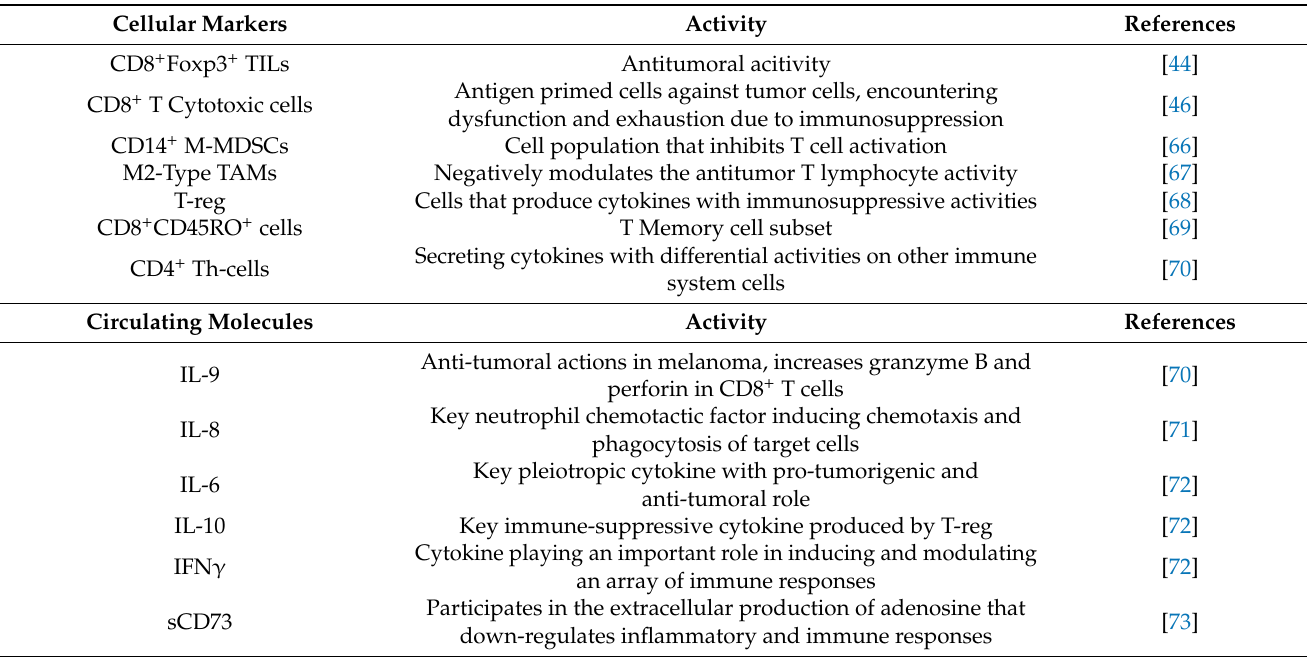
Table 1. Activity of predictive cellular and circulating biomarkers described in Figure 2. sCD73: soluble CD73, IFN: interferon, IL: interleukin, T-reg: regulatory T cell, M2-type TAMs: M2 tumor associated macrophages, M-MDSCs: monocyte- myeloid derived suppressor cells, Th-cells: T helper cells, TILs: tumor-infiltrating lymphocytes. Cellular